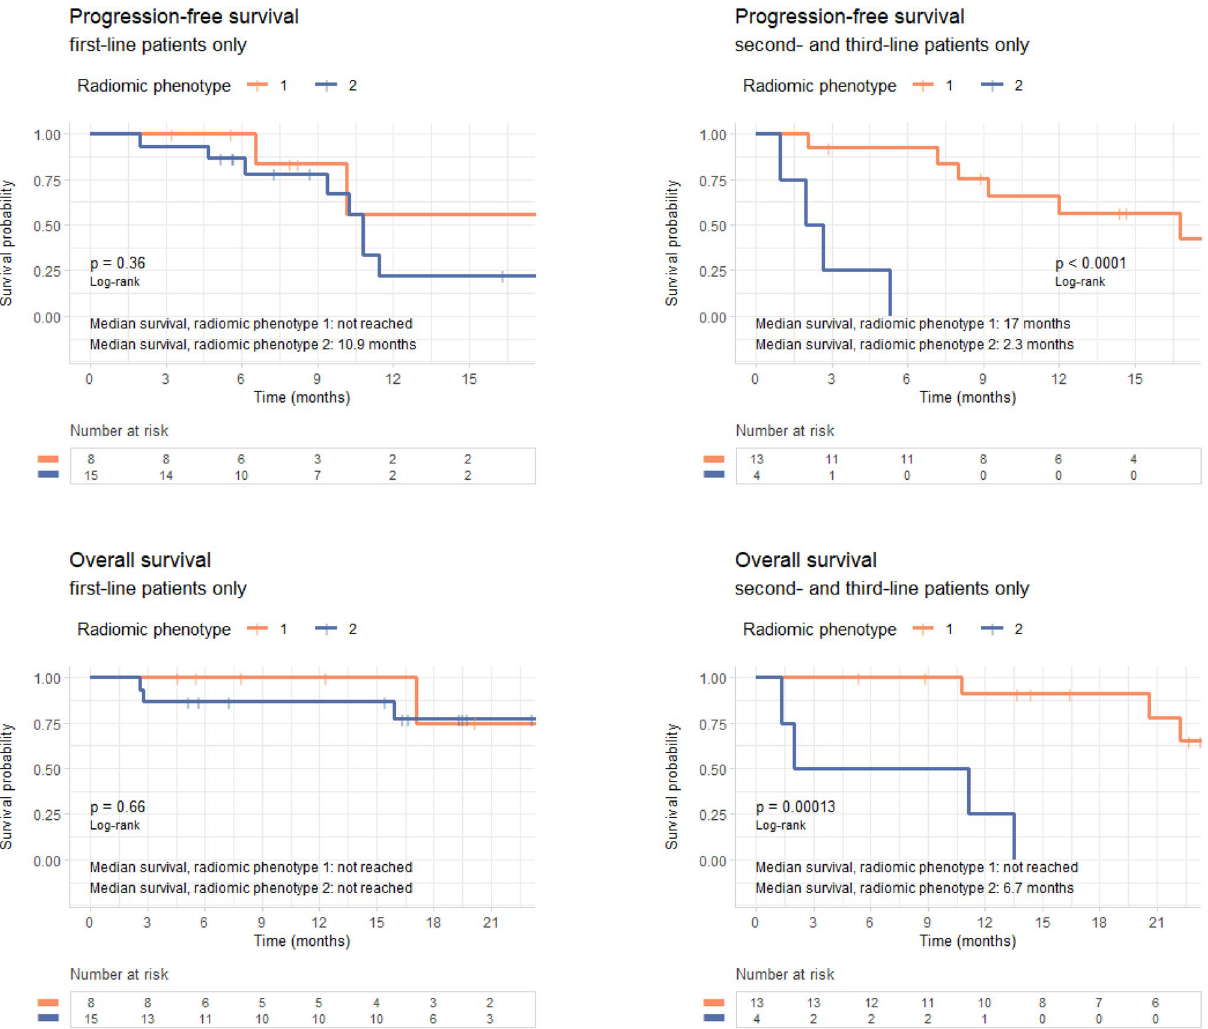
Figure 5. Survival analysis by line of therapy. Kaplan–Meier curves for (top row) progression-free survival and (bottom row) overall survival in first-line patients (left) and second- and third-line patients (right), showing that the radiomic tumor phenotypes can further sub-stratify patients in the second or third line of